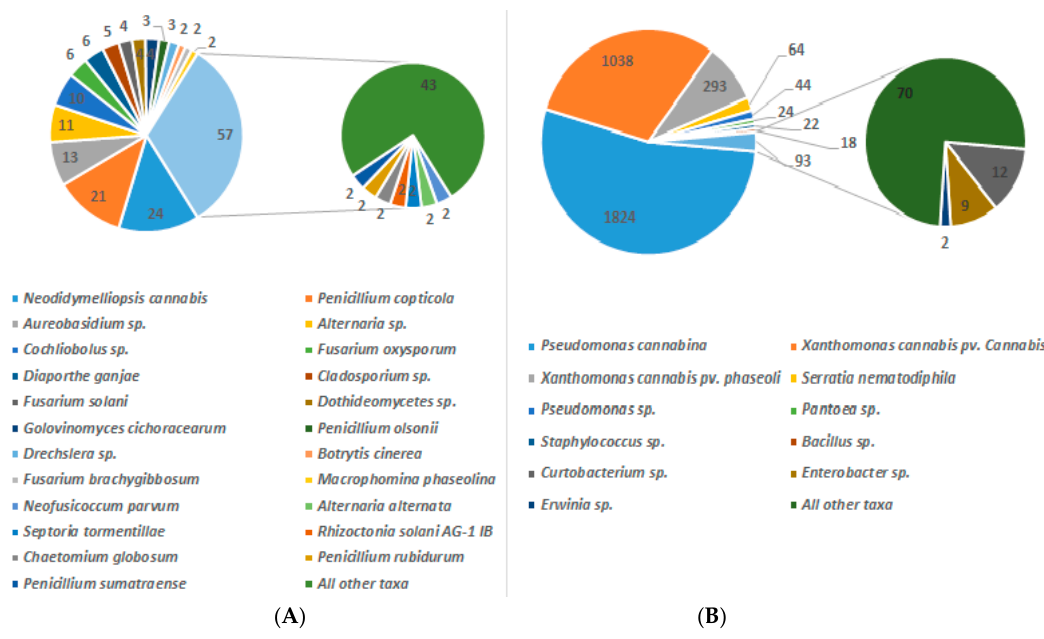
Figure 2. Diversity of Cannabis fungal taxa based on NCBI database: ≥ 2 ITS (internal transcribed spacer) rRNA sequences in NCBI ( A ) left panel; diversity of Cannabis bacterial taxa based on NCBI: ≥ 2 16S rRNA sequences ( B ) right panel (Data retrieved on 12 January 2019).